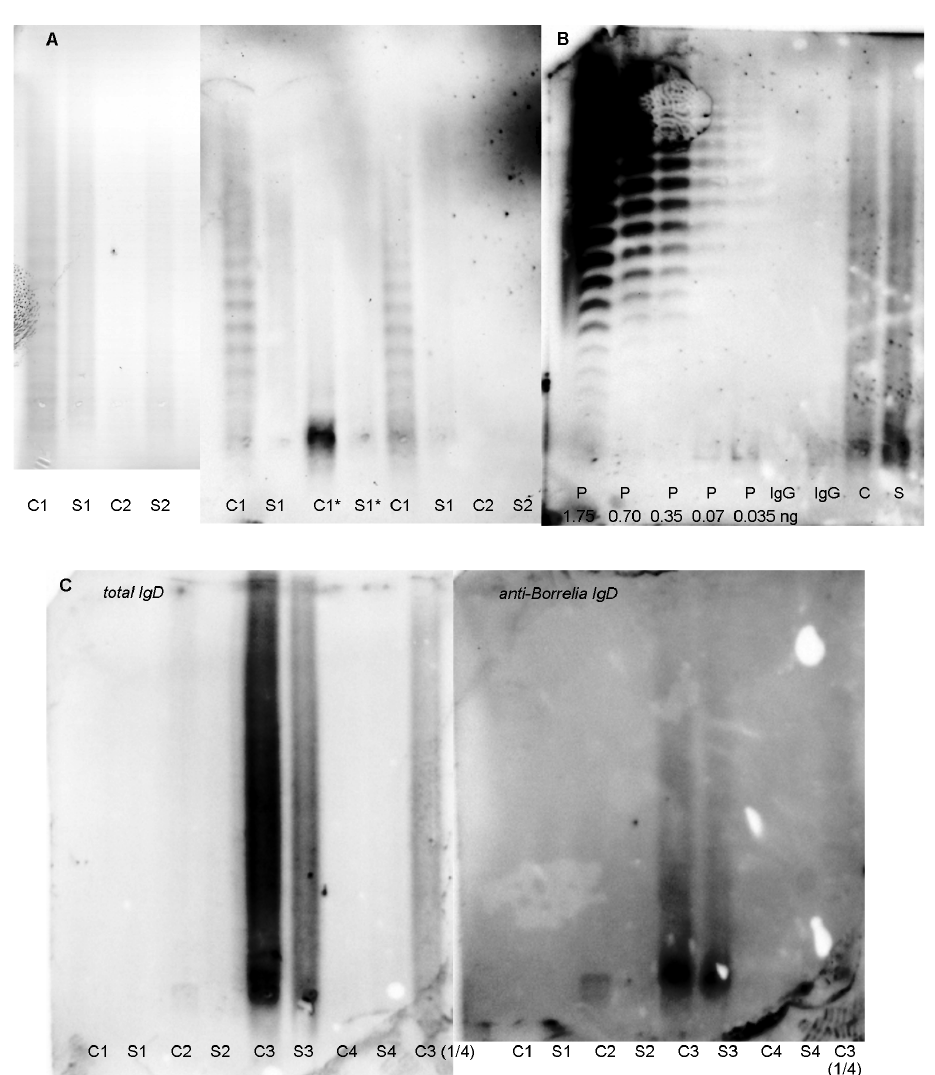
Fig. 3. A. Oligoclonal IgD in the CSF of a patient with relapsing meningoencephalitis of unknown cause. Left: chromogenic detection; right: CL detection (exposition time 569 s). C1*, S1*, cere- brospinal fluid and serum sample with protease inhibitor. B. Monoclonal IgD in serum of a patient with IgD kappa myeloma (P). The amounts of IgD applied in (P) were 1.75; 0.70; 0.35; 0.07 and 0.035 ng. Exposition time was 186 s. C. Total IgD (left; exposition time 4 s) and anti- Borrelia IgD (right; exposition time 20 s): a signal is observed in the CSF on the Borrelia burgdorferi purified protein coated membrane but the pattern seems to be polyclonal rather than oligoclonal. Western Blot Pico Plus substrate was used in A. while Western Blot Femto maximum sensitivity substrate was used in B. and